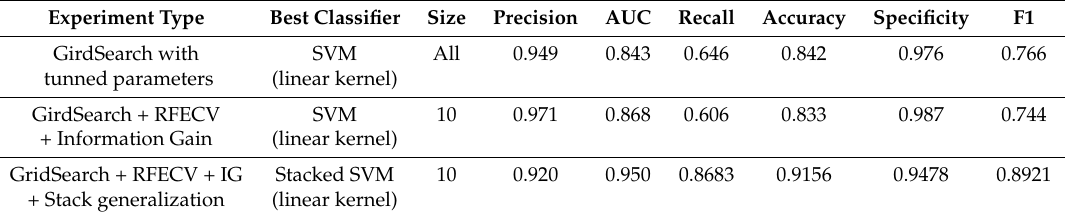
Table 4. Comparative best results of all three group of experiments with the proposed ensemble of feature selection and extraction techniques with